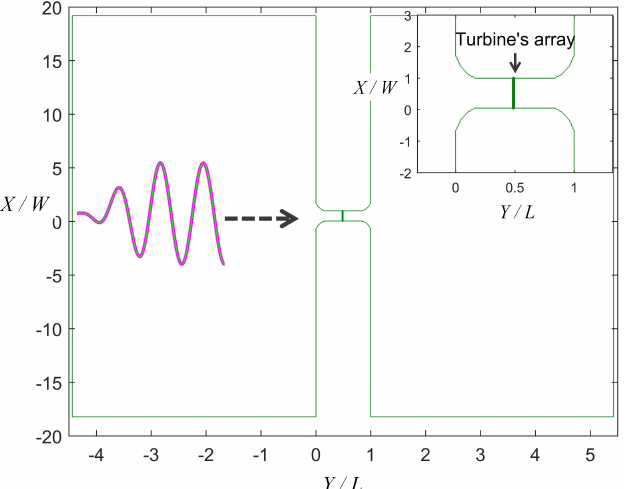
Figure 3. Tidal channel with a constant cross-section, which connected two large basins. An array of turbines was deployed in the middle of the